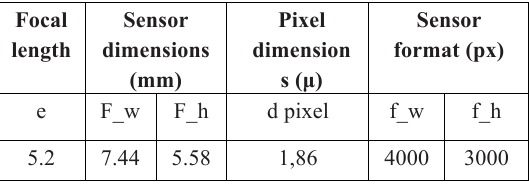
Table 8: Characteristics of the camera used.